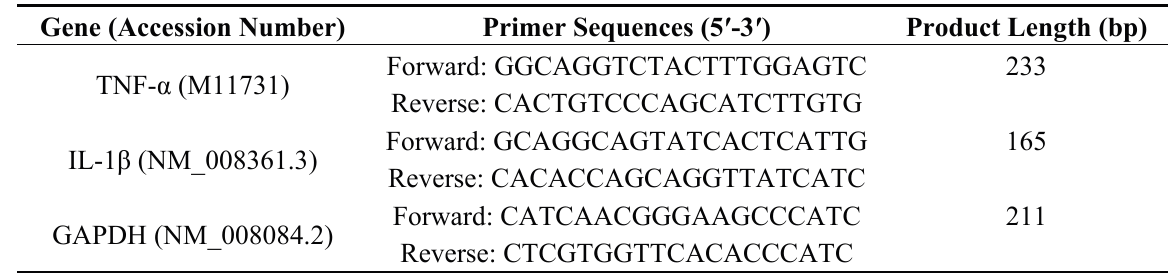
Table 1. PCR primers used in this study and the amplified product